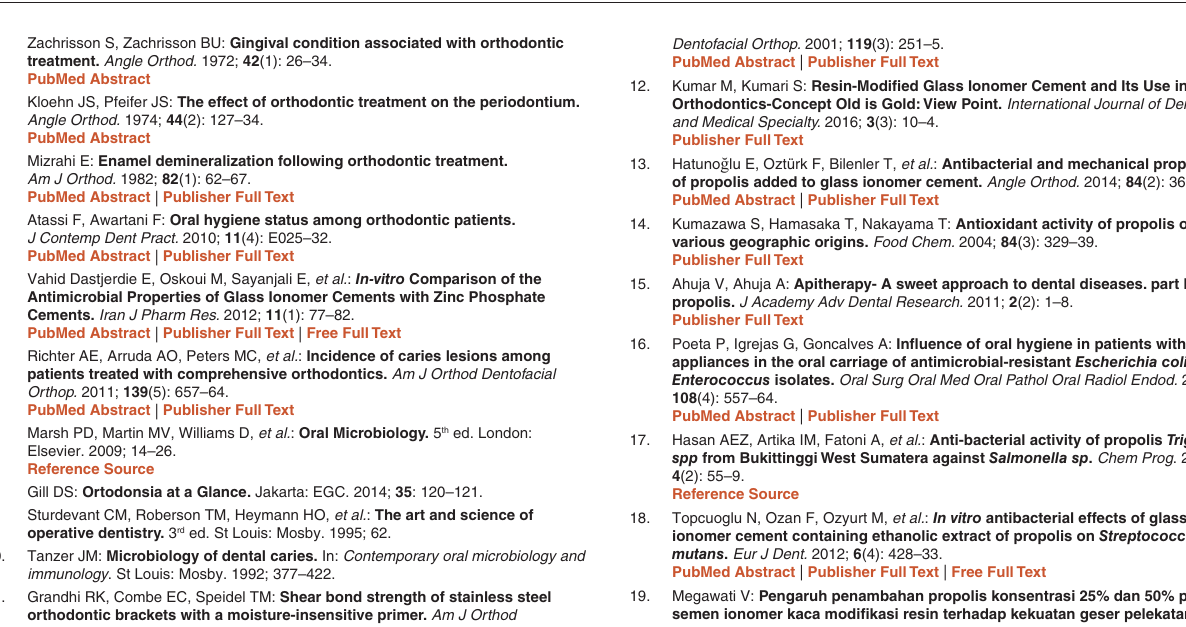
Figshare: Growth Inhibition Zone Around Resin-modified Glass Ionomer Cement Bracket Adhesive, https://doi.org/10.6084/ m9.figshare.10263275.v4 44